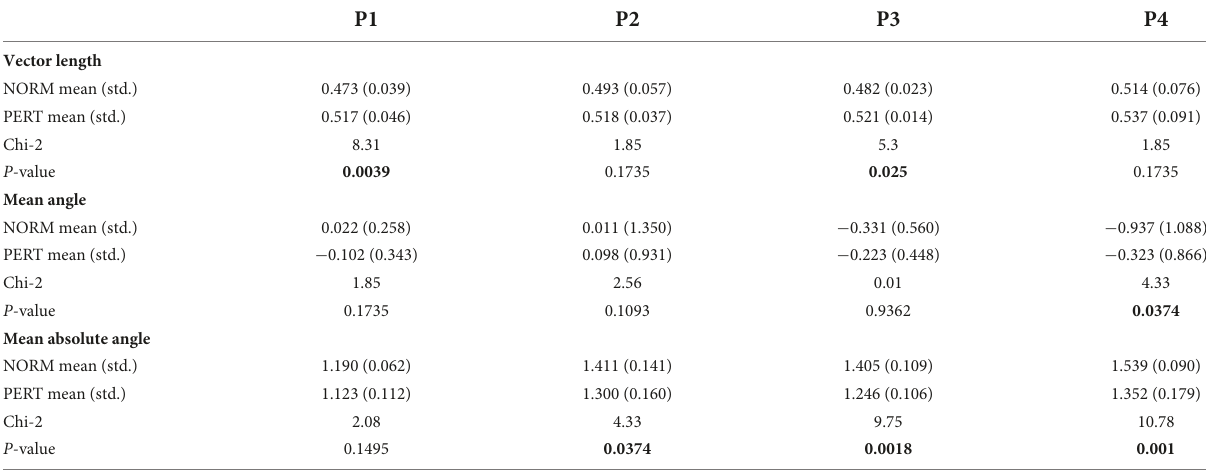
TABLE 6 Vector length (upper table), mean relative angle (in radians, middle table) and mean absolute angle (in radians, lower table) of the relative phase between head and bow motion, computed at each metrical timescale (P1 – P4), compared across experimental conditions. P1 P2 P3